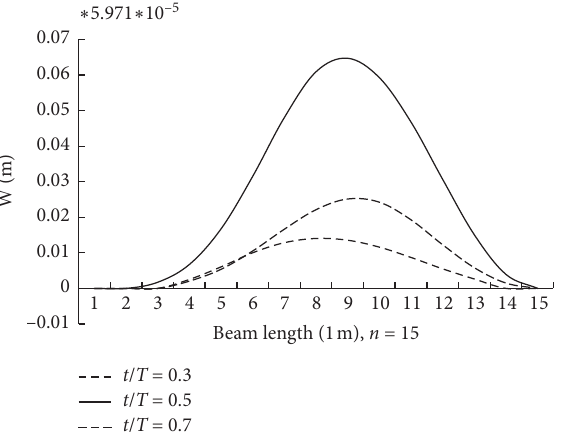
Figure 11: C-C beam (2) deflection, F �